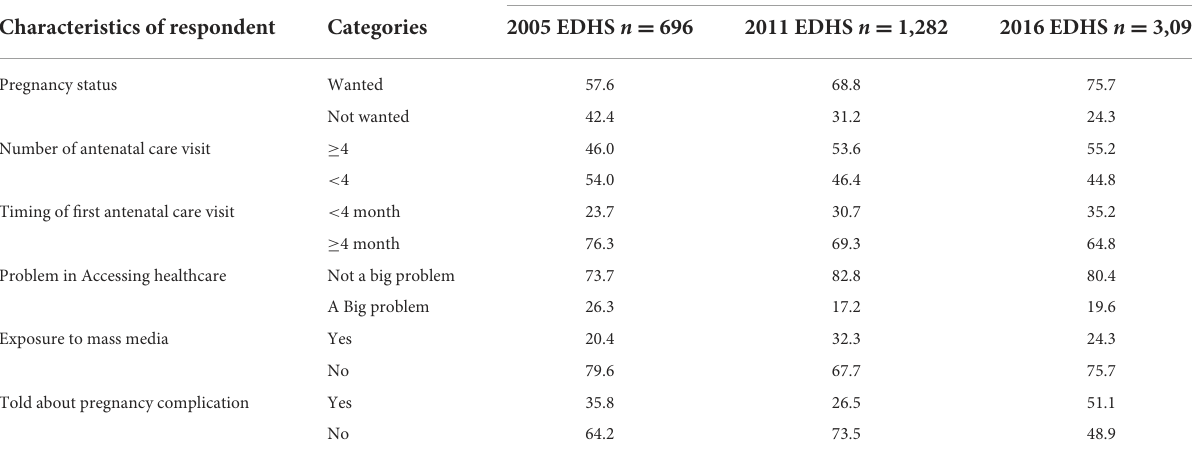
TABLE 2 Proportion of respondents with health service-related characteristics in Ethiopia based on the EDHS